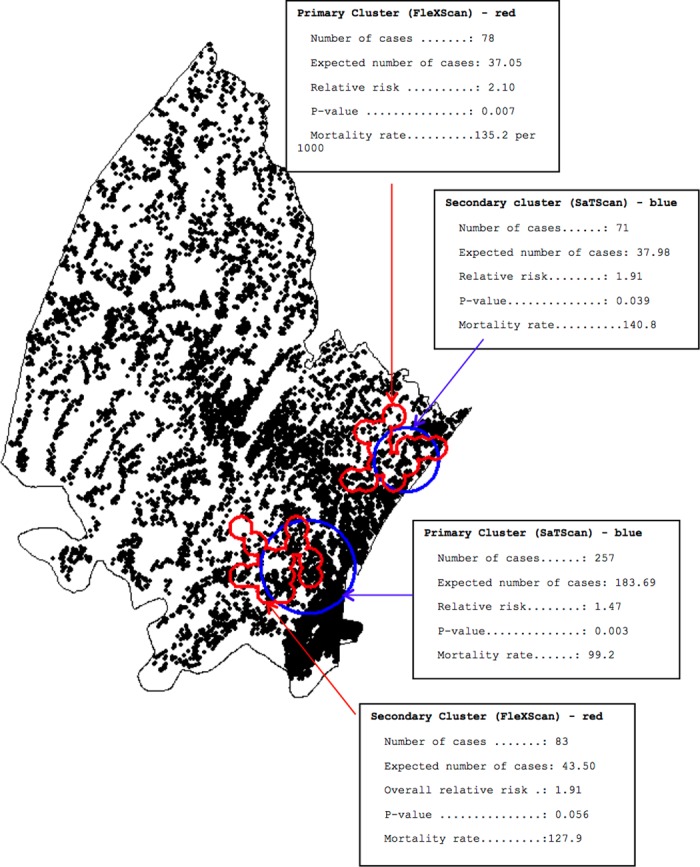
Spatial clustering of childhood mortality (Kulldorff and Tango spatial scan statistics) [maximum 25% population at risk in scan window].